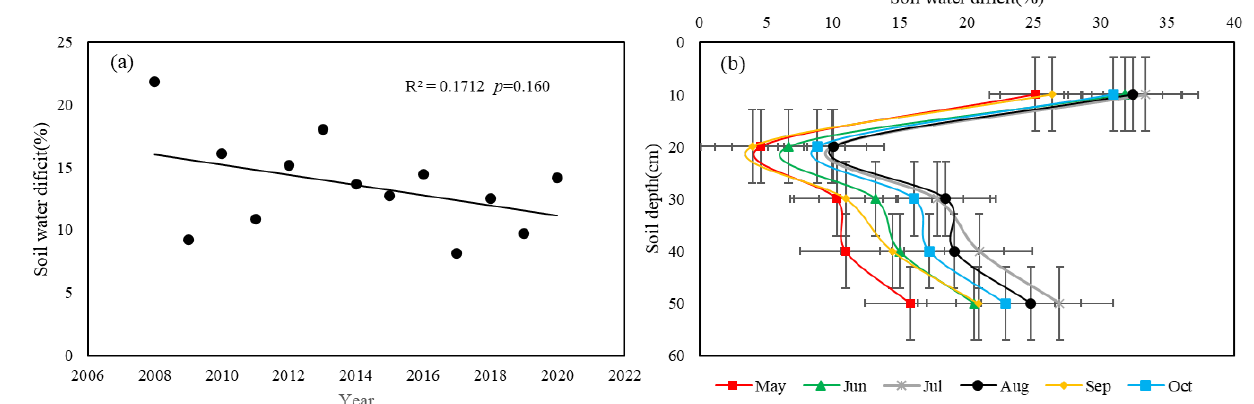
Figure 5. Inter-annual and vertical variation of soil water deficit. ( a ) Indicates interannual variation of soil water deficit, and ( b ) indicates vertical variation of soil water deficit in different of growth season.